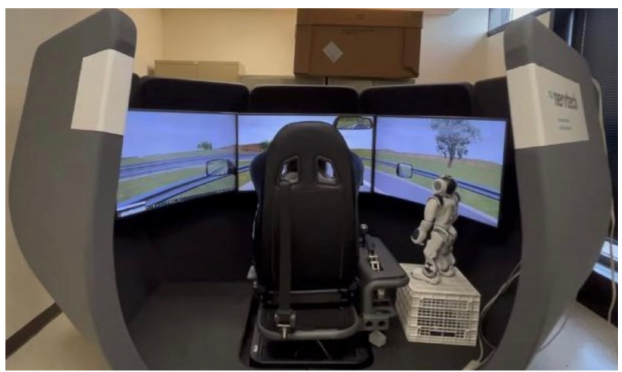
Figure 2. Experiment setup: Nervtech TM driving simulator with the